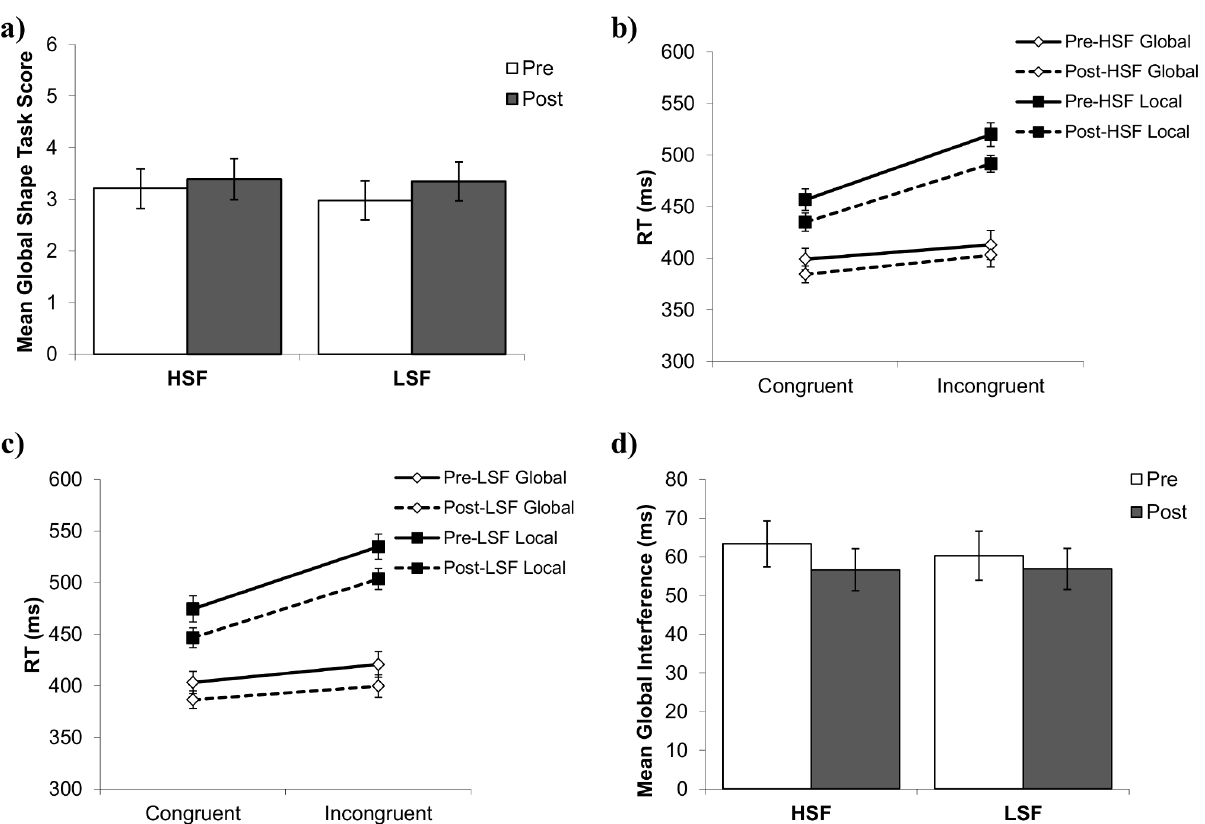
Figure 3. Experiment 1a and b pattern of means. (a) Experiment 1a mean pre- and post-manipulation global shape task scores as a function of manipulation frequency (HSF or LSF faces). (b) Experiment 1b mean RTs on the Navon letter task, as a function of pre- and post-manipulation, stimulus level (global or local), and target congruency in the HSF condition and (c) in the LSF manipulation condition. (d) Experiment 1b mean pre- and post-manipulation global Navon interference scores as a function of viewing LSF or HSF faces in the manipulation task. Error bars in this and all other figures represent the standard error for each condition mean.